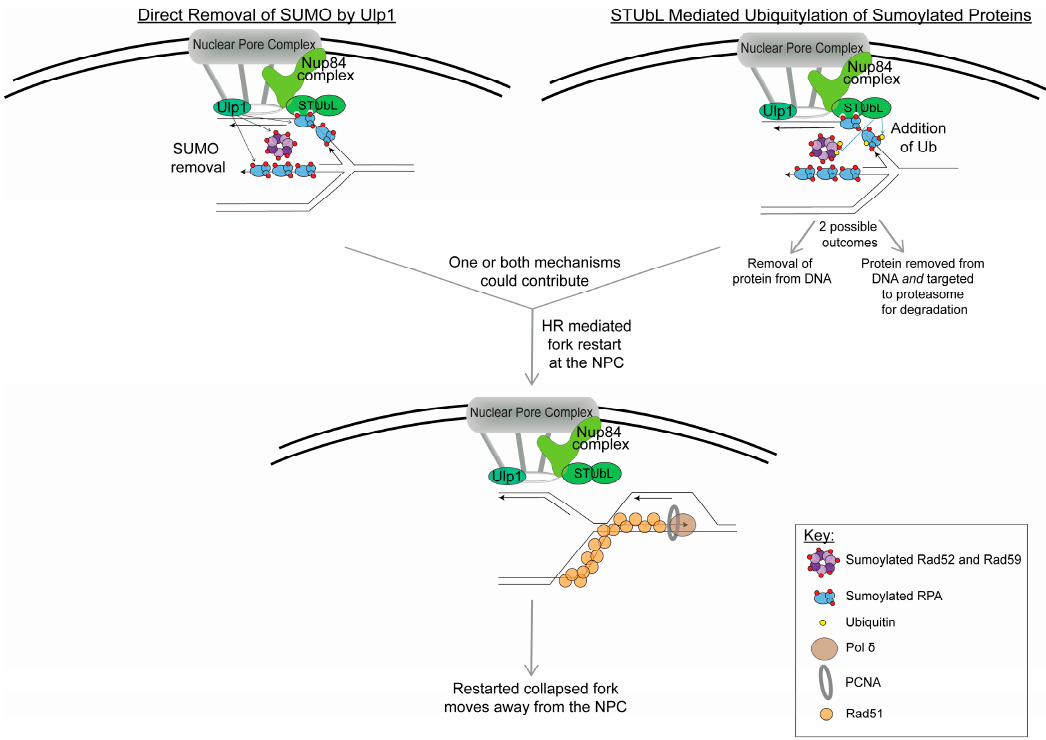
Figure 2. Model for events happening at the NPC to restart collapsed replication forks. Based on current data, the regulation of sumoylated proteins on the replication fork located at the NPC could occur by two mechanisms: (1) direct removal of SUMO by Ulp1 (which is bound to the NPC) and (2) STUbL-mediated ubiquitylation of sumoylated proteins (ubiquitin is indicated by yellow circles). It is important to note that both mechanisms could be happening at the same time at the collapsed replication fork. The STUbL-mediated ubiquitylation could either result in removal of the sumoylated proteins from the replication fork or it could target the sumoylated proteins to the proteasome for degradation or both. The removal and / or degradation of sumoylated proteins from the stalled replication fork is presumed to facilitate fork restart. Current data points to Rad51-dependent HR-mediated fork restart occurring while the collapsed replication fork is at the NPC; however, other outcomes at the NPC are possible, such as the resolution of HR intermediates or a converged fork. In this model, after the collapsed fork is restarted, it no longer remains at the NPC.